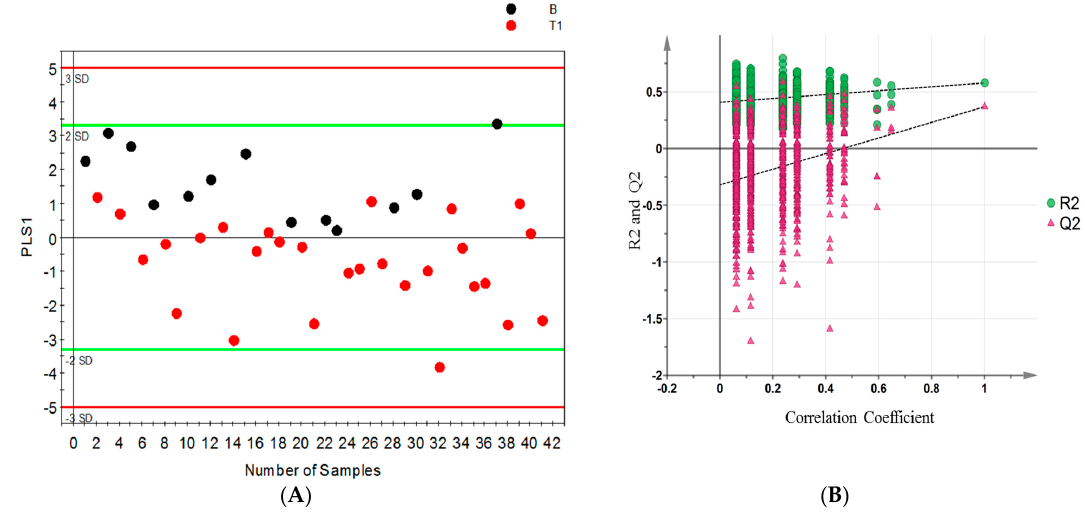
Figure 3. OPLS-DA model differentiating benign (B) from stage 1 (pT1) patients; ( A ) scores scatter plot; and ( B ) permutation plot from 999 permutation tests with Q2 intercept of − 0.27 (the more negative the Q2 intercept, the more valid the model).